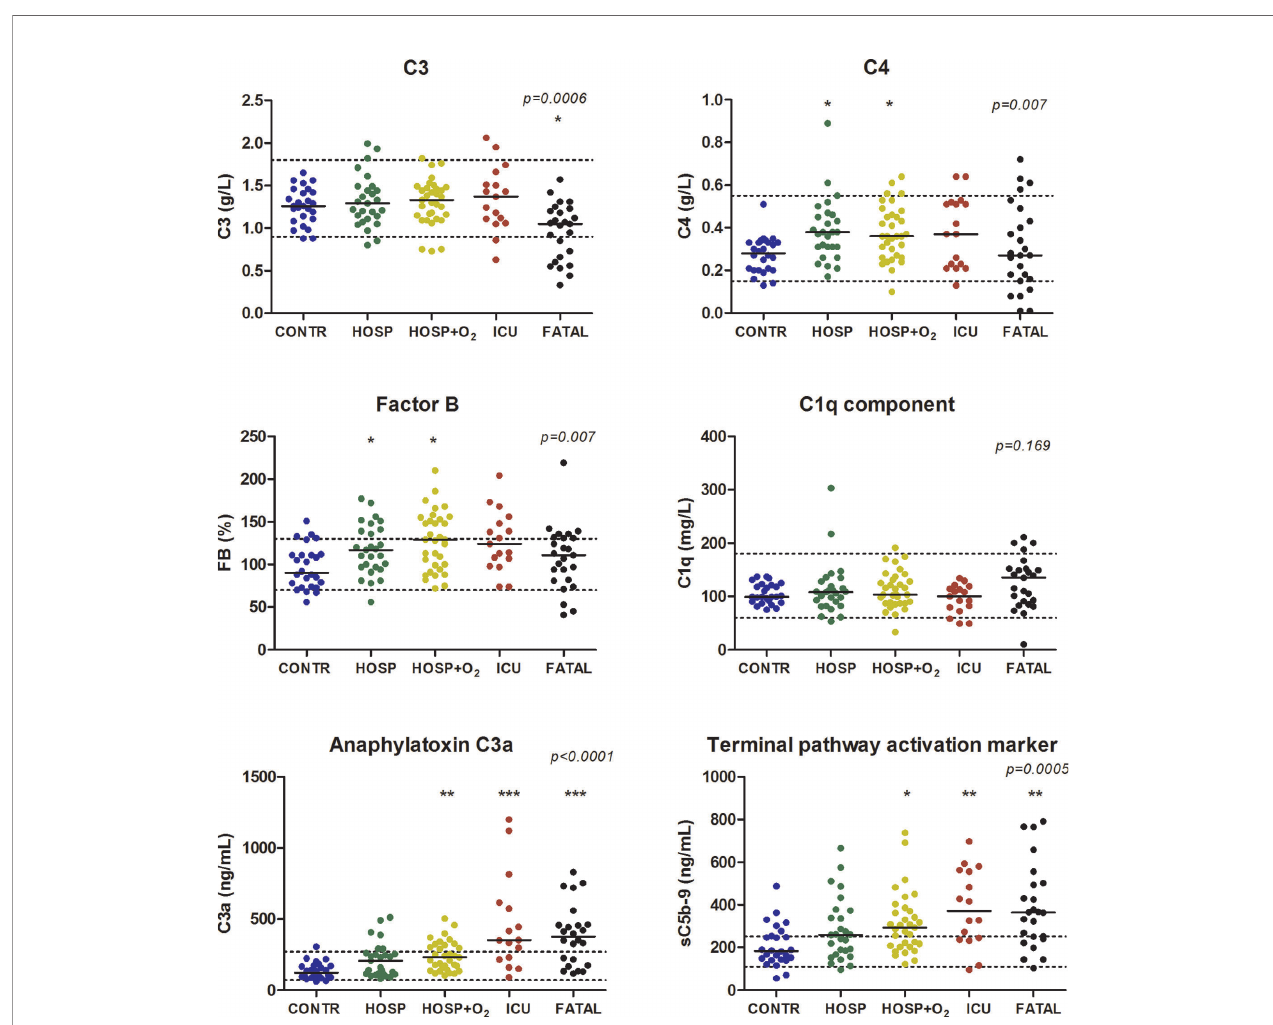
FIGURE 4 | Association between complement parameters and peak severity of SARS-CoV-2 infection. The horizontal solid lines indicate group median, horizontal dashed lines indicate reference range limits, p-values were obtained by Kruskal-Wallis test; asterisks indicate results of Dunn ’ s post test (*p < 0.05, **p < 0.01, and ***p < 0.001), when compared to